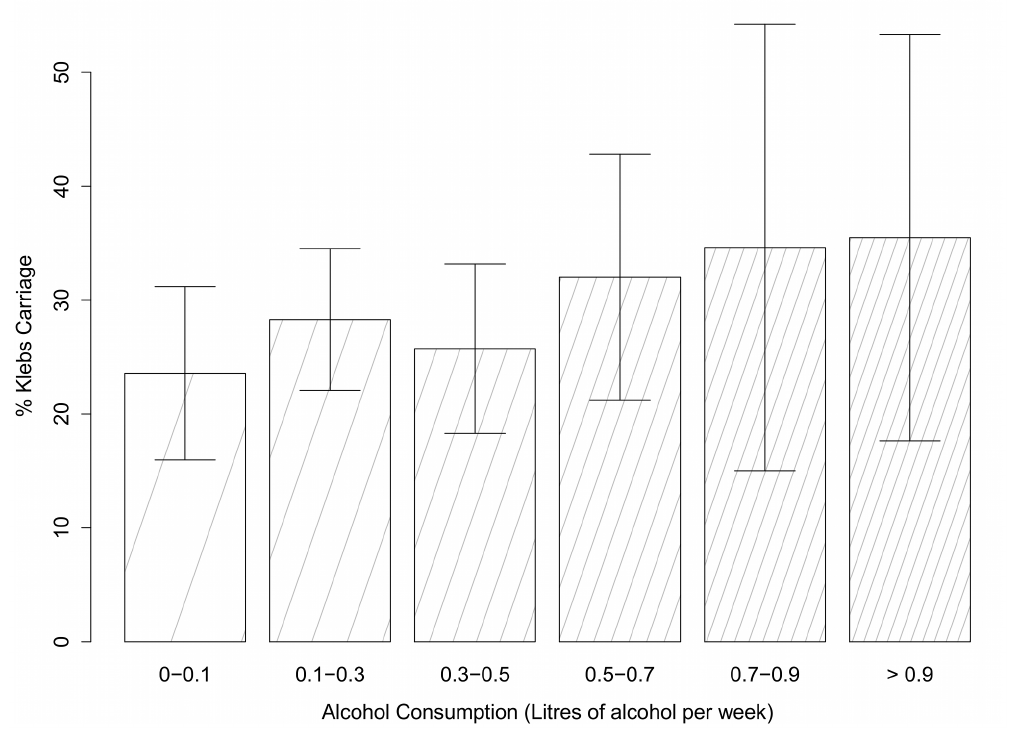
Figure 2. Prevalence of nasopharyngeal carriage of K.pneumoniae by level of weekly alcohol consumption – alcohol cohort. Subjects are from the alcohol cohort, consisting of 613 male adults from Ba Vi (rural) that provided alcohol consumption information. Alcohol consumption per week incorporates type of alcohol consumed, amount consumed, and days per week consumed.